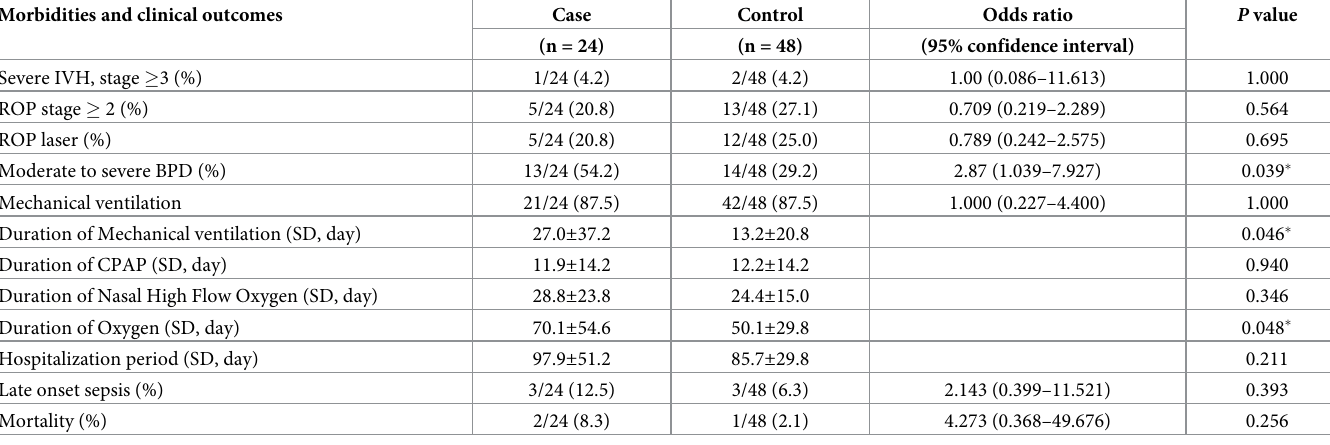
Table 2. Comparison of clinical outcomes between case and control group.